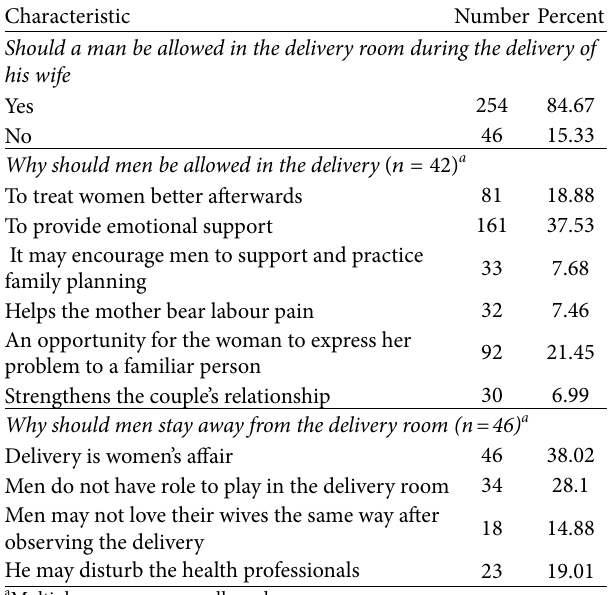
Table 4: Women's perspective on male partner companionship during labour and